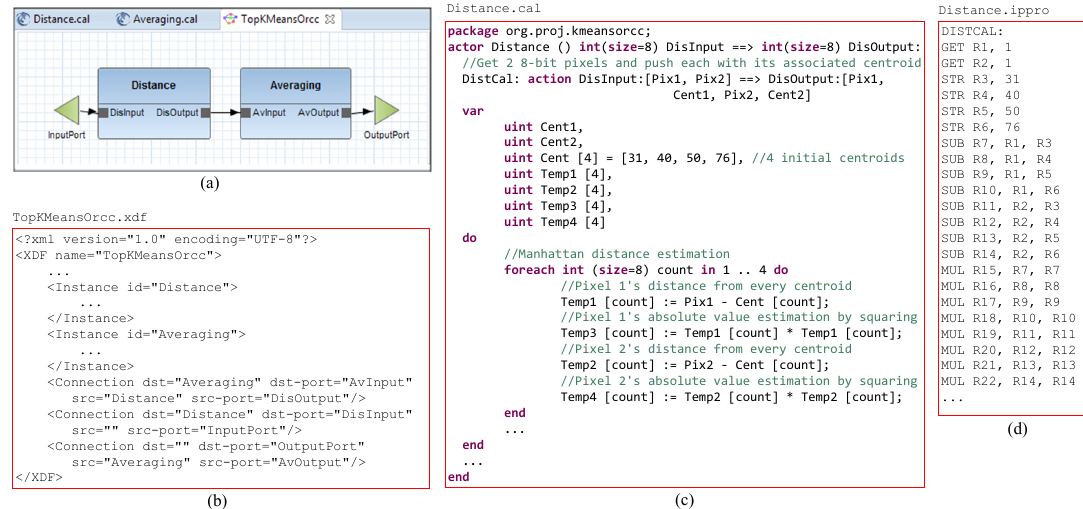
Figure 10. High-level implementation of k -means clustering algorithm: ( a ) Graphical view of Orcc dataflow network; ( b ) Part of dataflow network including the connections; ( c ) Part of Distance.cal file showing distance calculation in RVC-CAL where two pixels are received through an input FIFO channel,